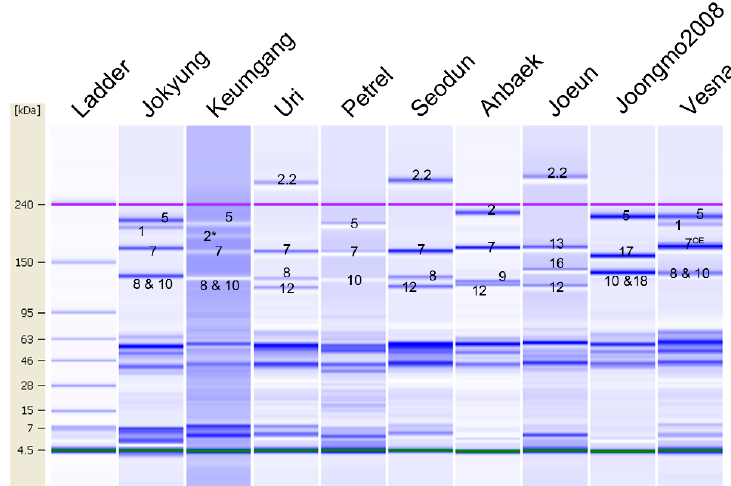
Figure 1. Gel-like image of the standard varieties on Lab-on-a-chip. Six microliters of diluted extracted glutenin proteins with denaturing solution, including in the protein 230 assay kit, were separated by the 2100 Bioanalyzer. The upper marker (240 kDa) was adjusted before analyzing the high-molecular-weight glutenin subunit (HMW-GS) for varieties harboring 1Dx2.2, such as Uri, with the 2100 Expert program. Then, a gel-like image was taken. The purple line indicates the systematic upper marker (240 kDa). The small numbers on the image mean each HMW-GS such as 5 is 1Dx5 and 1 is 1Ax1.